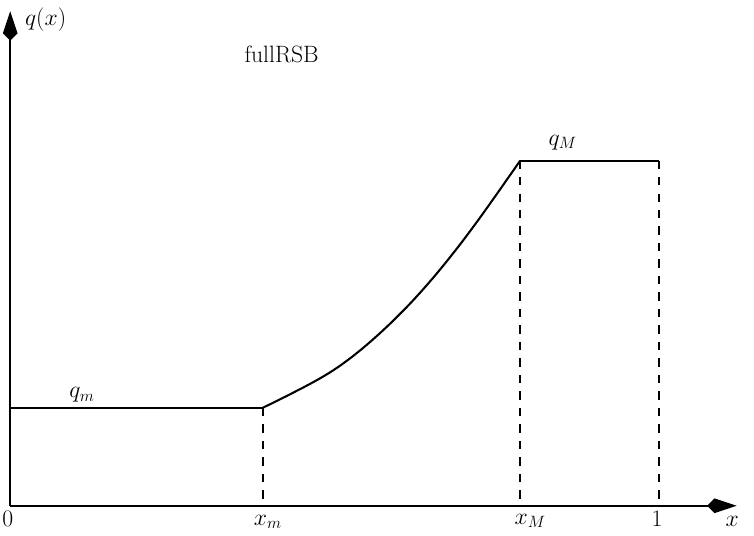
Figure 1: The expected form of the function q ( x ) in the fullRSB